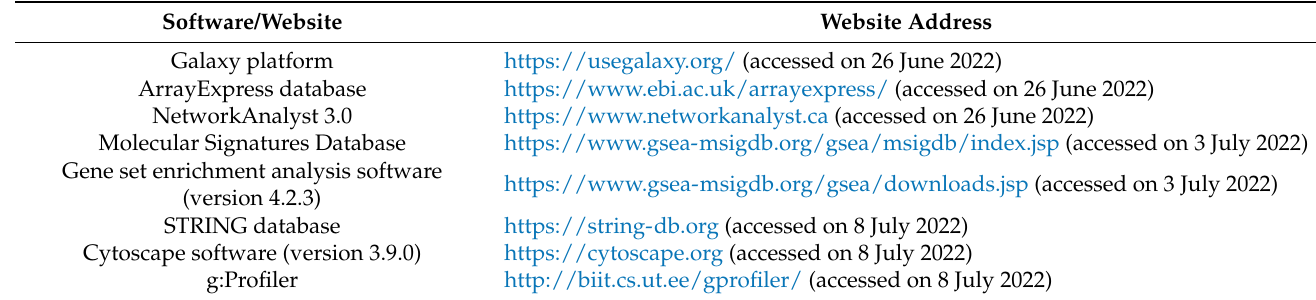
Table A2. Software and websites used in this